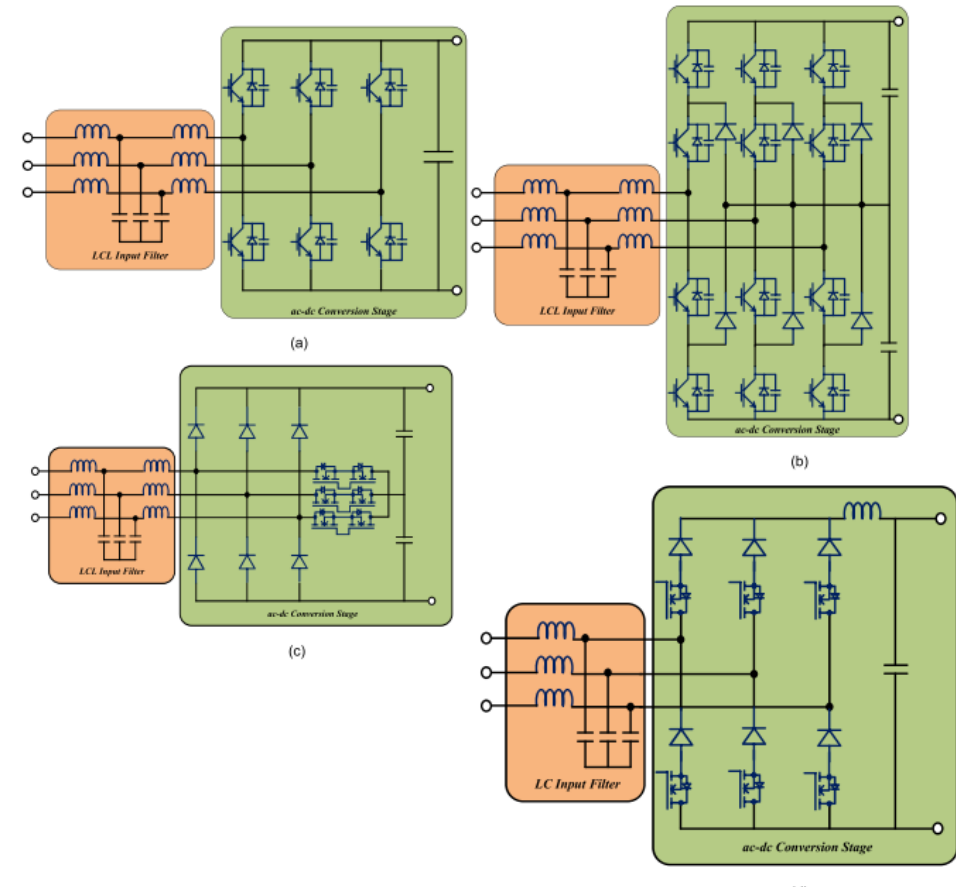
Figure 6. AC–DC front ‐ end topologies for DCFCs: ( a ) three ‐ phase PWM rectifier; ( b ) NPC rectifier; ( c ) Vienna rectifier; ( d ) buck ‐ type rectifier. (Reprinted from Ref. [8].)